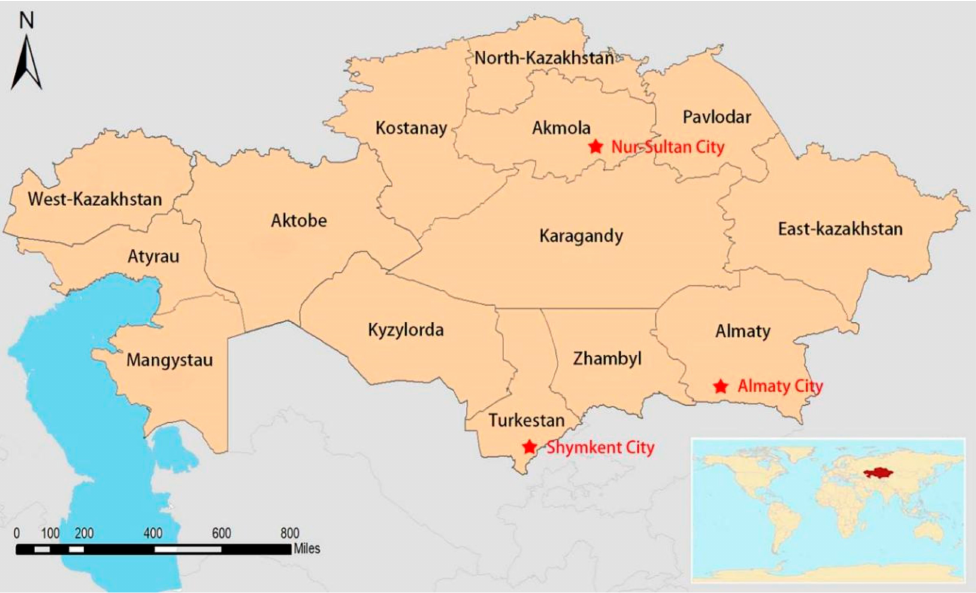
Figure 1. An administrative map of Kazakhstan.